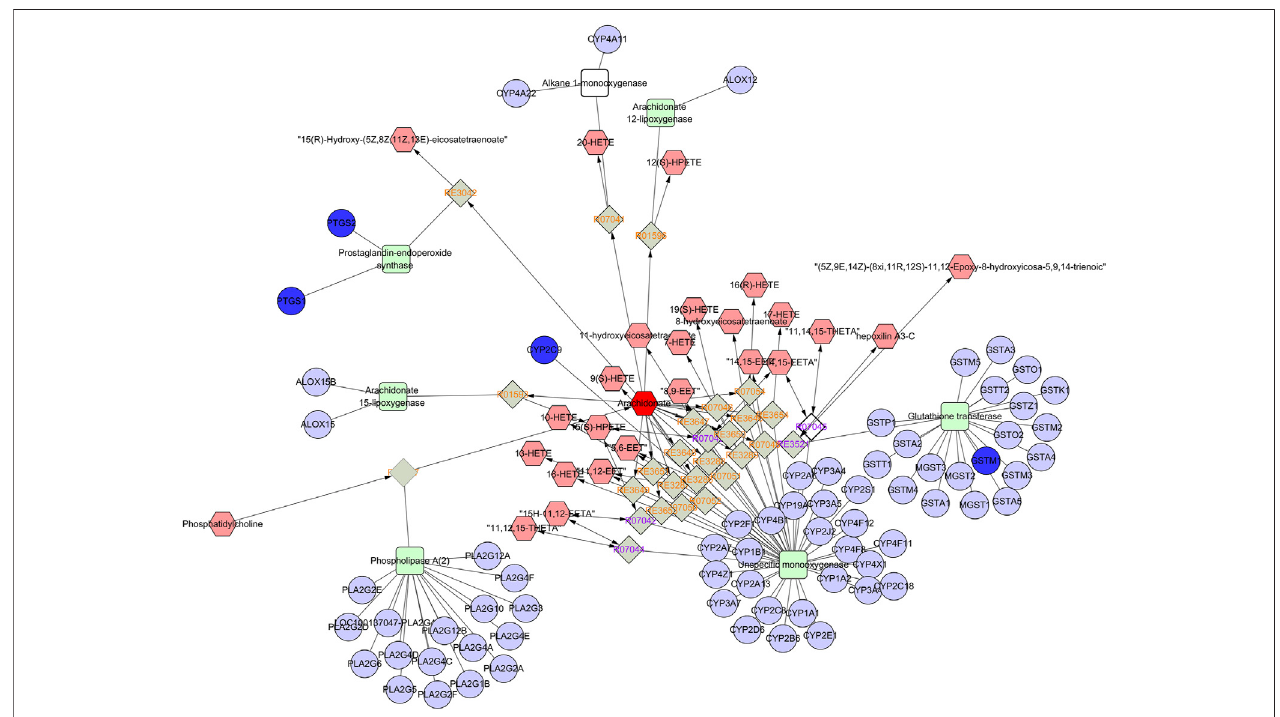
FIGURE9| Partofcompound-reaction-enzyme-genenetwork(Arachidonicacidmetabolism).Redhexagons,graydiamonds,greenrectangles,andpurplecircles represent active compounds, reactions, proteins and genes, respectively.